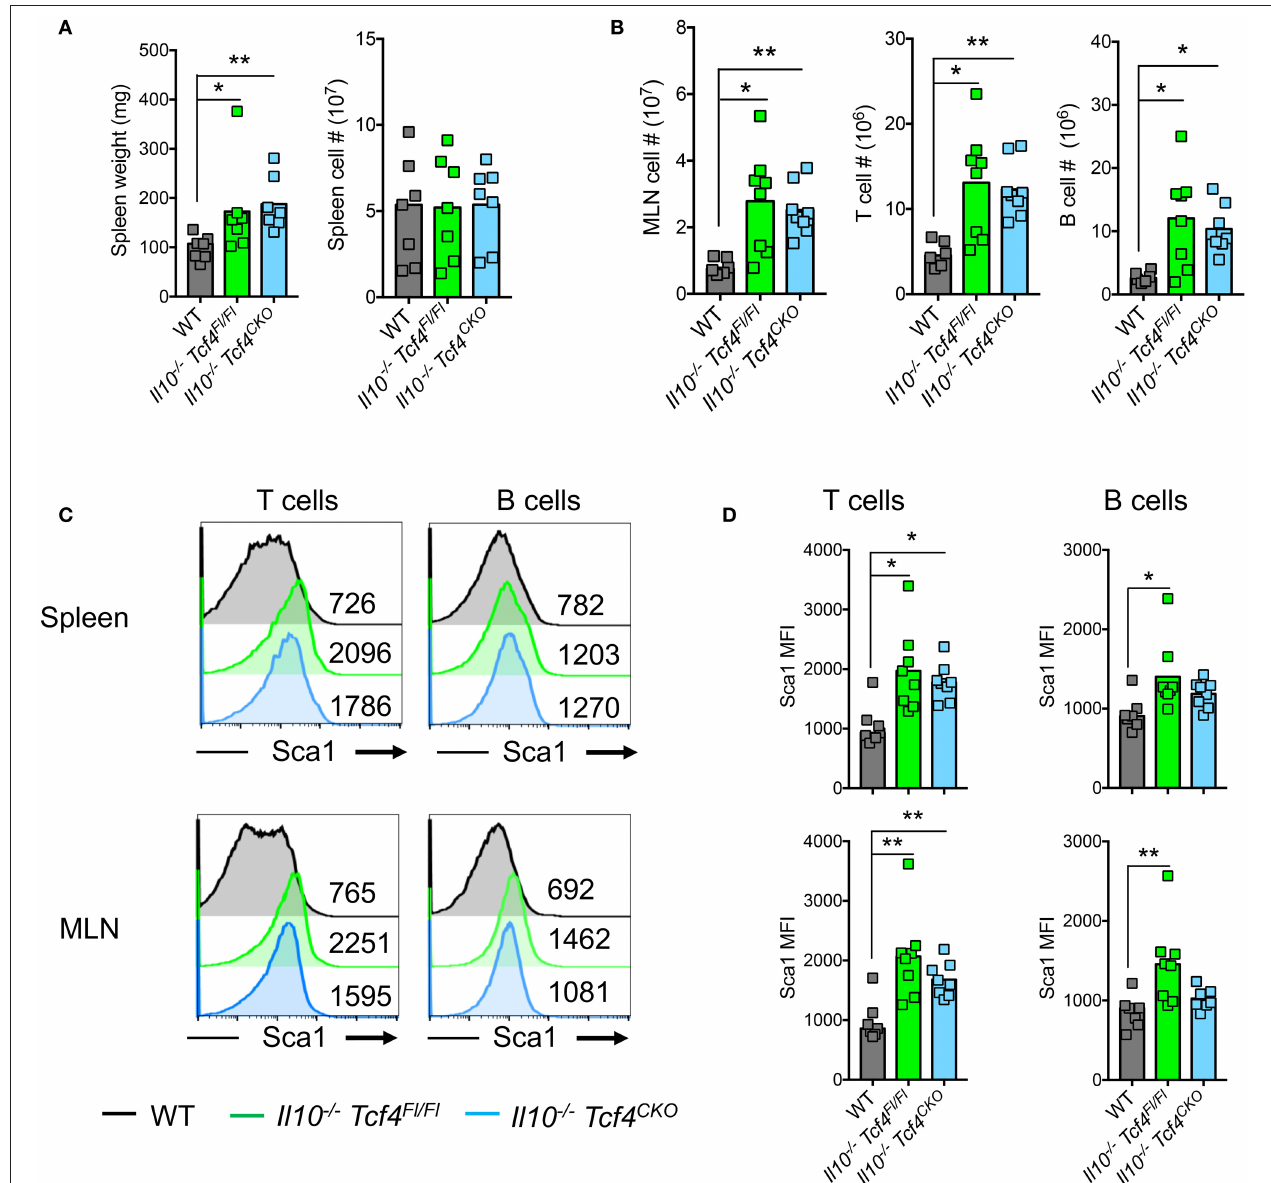
FIGURE 6 | DC-specific deletion of Tcf4 does not impact the overall immune activation in Il10 -deficient mice. Il10 − / − Itgax -Cre − Tcf4 flox / flox ( Il10 − / − Tcf4 Fl / Fl ) or Il10 − / − Itgax -Cre + Tcf4 flox / flox ( Il10 − / − Tcf4 CKO ) littermates with DC-specific Tcf4 CKO were analyzed along WT controls at 15 weeks of age. (A) Spleen weight and cellularity of individual animals were measured. (B) MLN cellularity and the absolute numbers of (TCRß + ) T cells and (B220 + ) B cells were determined by flow cytometry from individual mice. (C,D) Sca1 expression on (TCRß + ) T cells and (B220 + ) B cells from the spleen and MLNs was assessed by flow cytometry. (C) Histograms show representative analysis of Sca1 expression and the MFI of Sca1 is indicated in each plot and (D) plots show Sca1 MFI of individual animals. In all plots, horizontal bars represent the median. Data for all panels pooled from 3 independent experiments. Statistical significance estimated by Kruskal-Wallis test followed by a post-hoc Dunn’s multiple comparison test is indicated as follows * P ≤ 0.05, ** P ≤